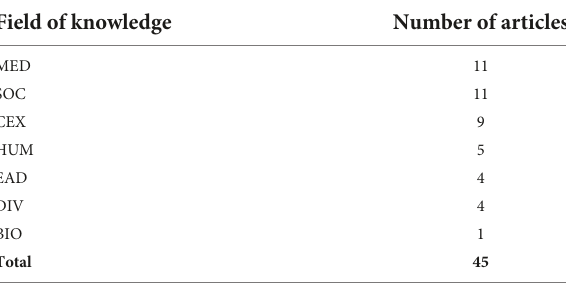
TABLE 5 Conceptual-methodological commitment (perspectives and methodologies). Perspective